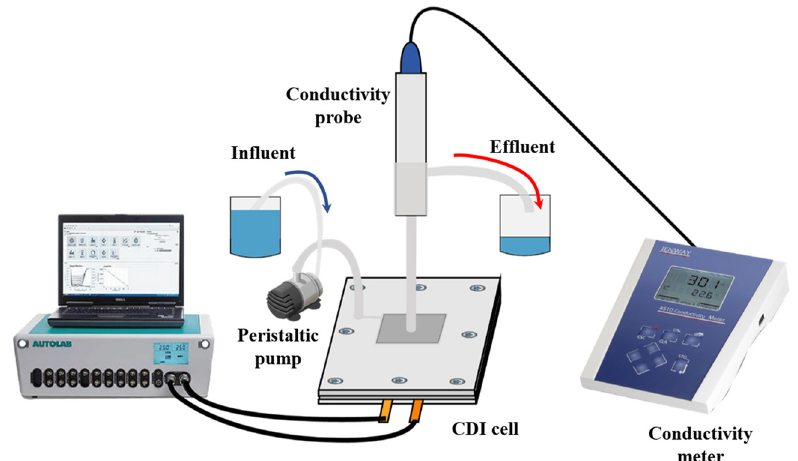
Figure 1: Schematic illustration of CDI